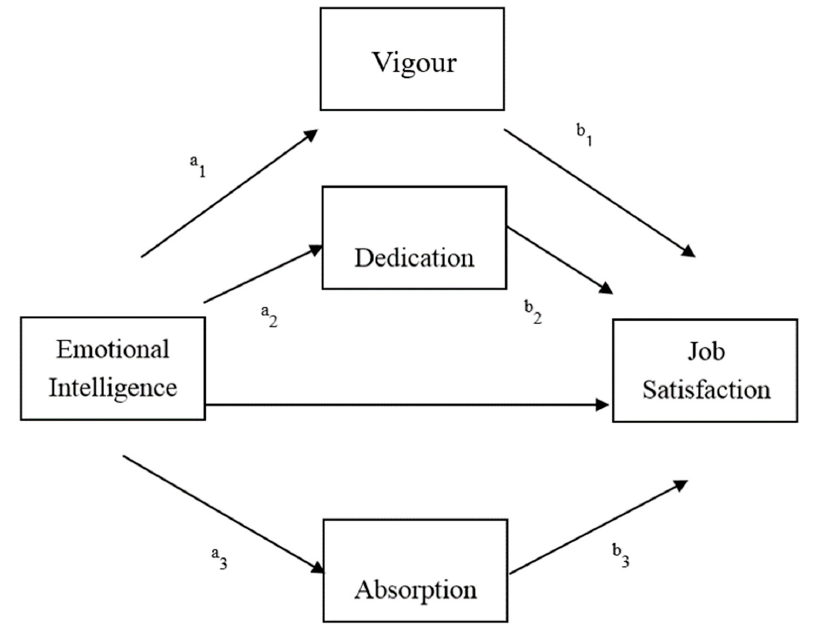
Figure 1. Proposed model of the role of work engagement dimensions in explaining job satisfaction. ** p < 0.01.